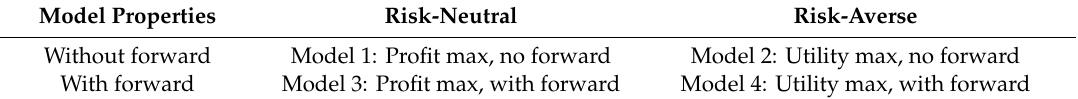
Table 1. Model properties.